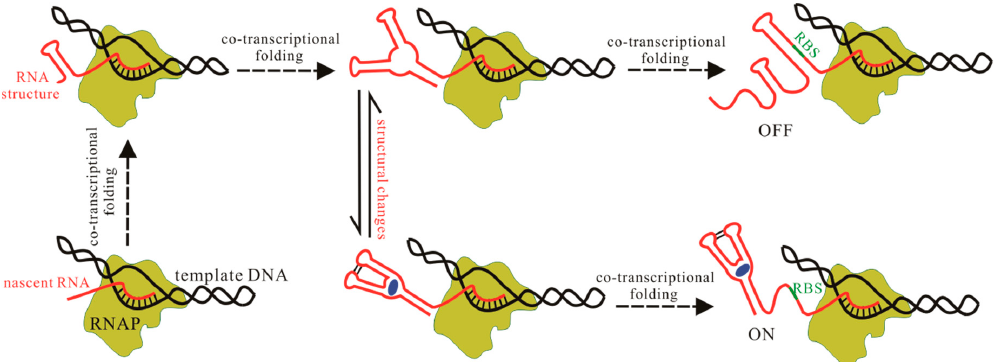
Figure 2. Schematic representation of riboswitch behaviors in cells. Nascent chain of the riboswitch and the ligand are colored red and blue respectively. The green line denotes the ribosome binding site (RBS) and RNA polymerase (RNAP) is denoted by yellow-green. The structure, structural changes, and co-transcriptional folding should be investigated for fully understanding the regulation mechanisms of riboswitches.